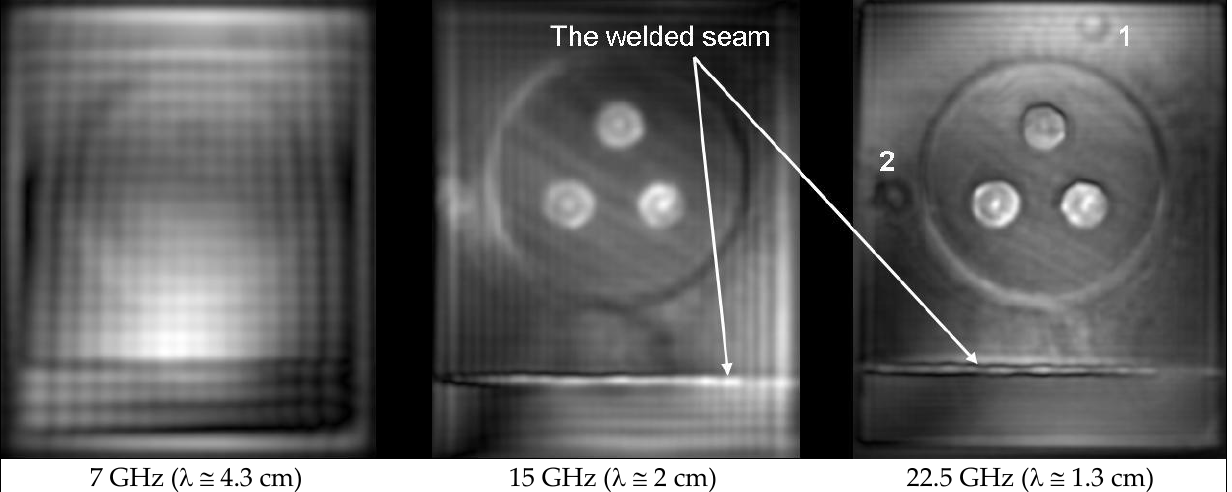
Figure 25. HSR images of the aerospace materials test sample with intentional (and unintentional) defects.